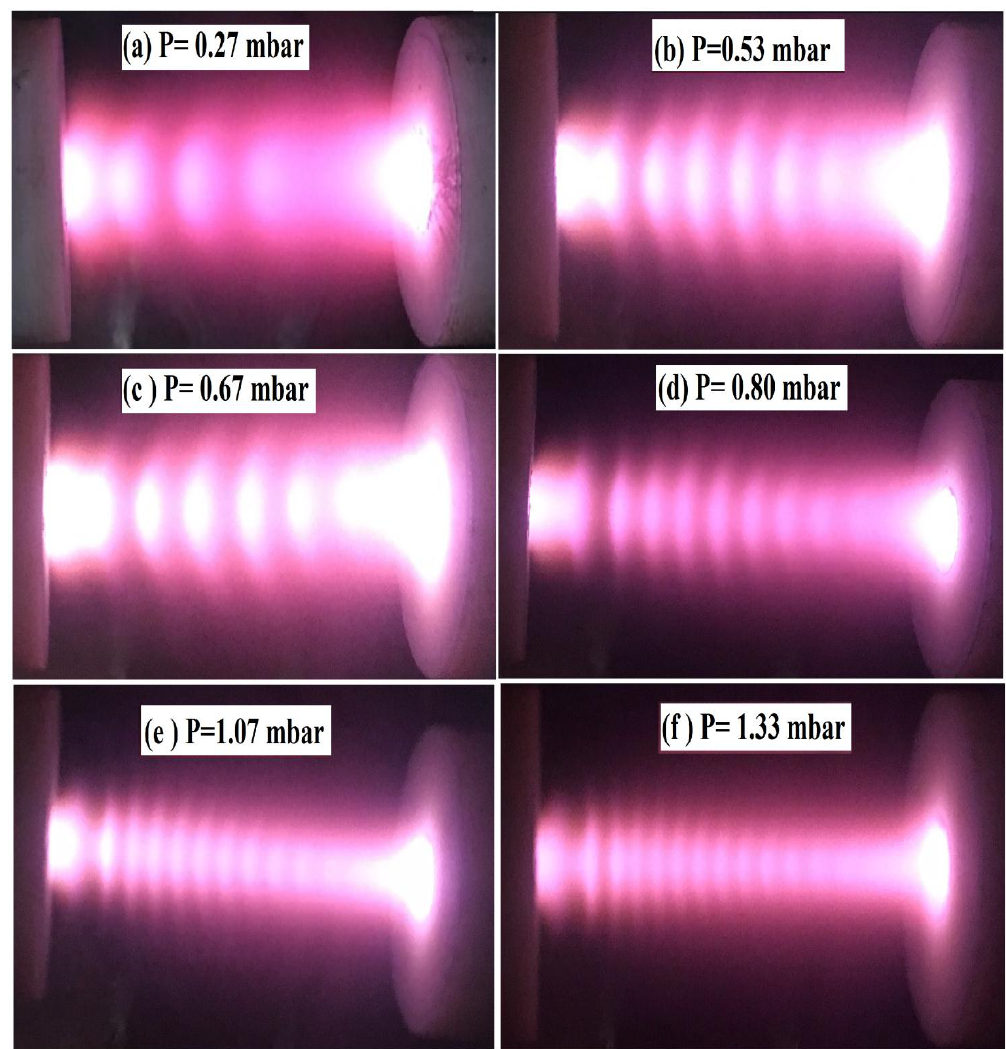
Fig. 3: Effect of Ar gas pressure on the glow discharge structure of the hollow cathode system without magnetic